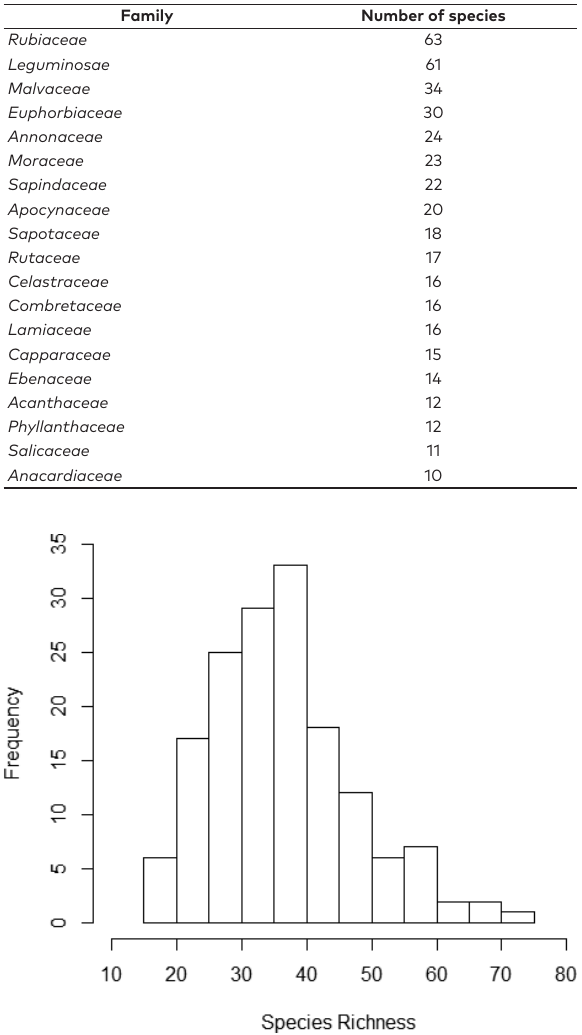
Figure 2. Distribution of species richness per plot in the Kenyan coastal forests vegetation-plot database (n = 158